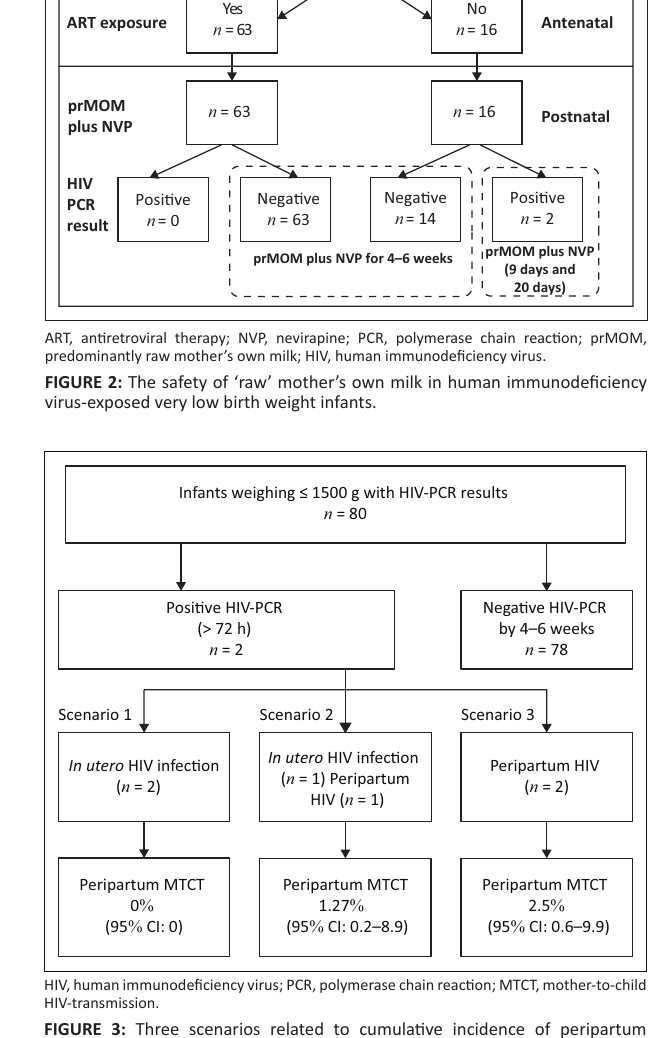
FIGURE 3: Three scenarios related to cumulative incidence of peripartum human immunodeficiency virus transmission by 4–6 weeks.